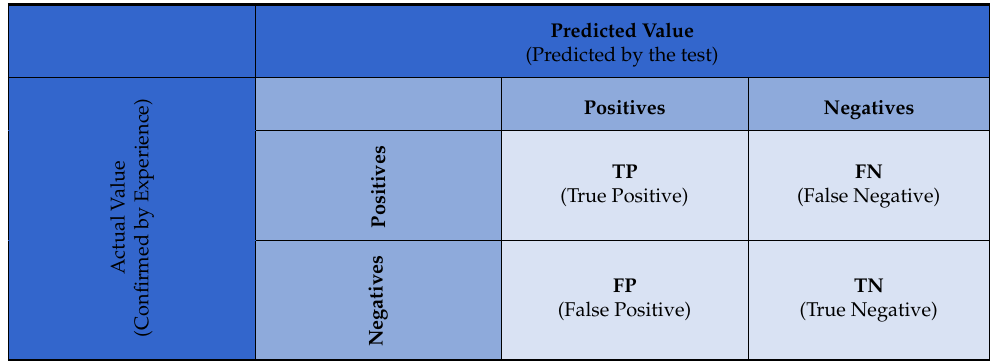
Table 1. Confusion matrix for predictive modeling of target